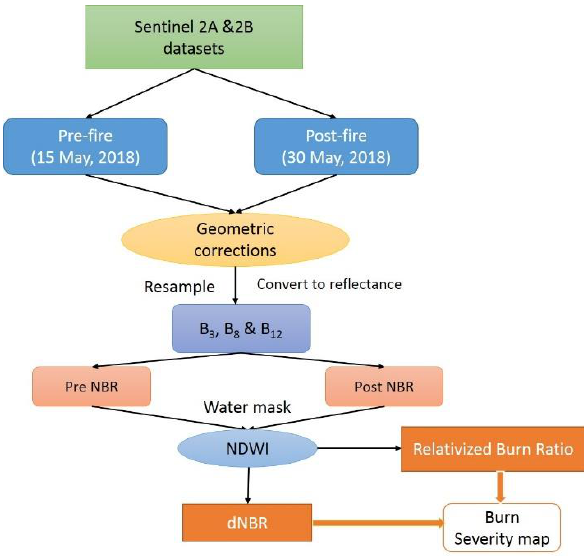
Figure 2. Methodology flow chart shows the generation of burn severity